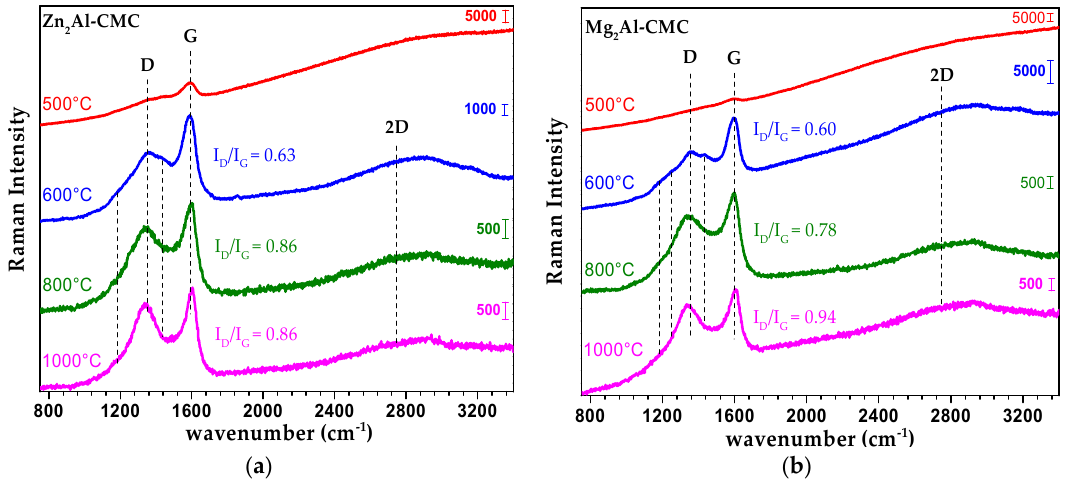
Figure 6. Raman spectra of Zn 2 Al-CMC ( a ) and Mg 2 Al-CMC ( b ) samples pyrolyzed at 500, 600, 800 and 1000 °C under N 2 atmosphere ( λ exc = 532 nm).